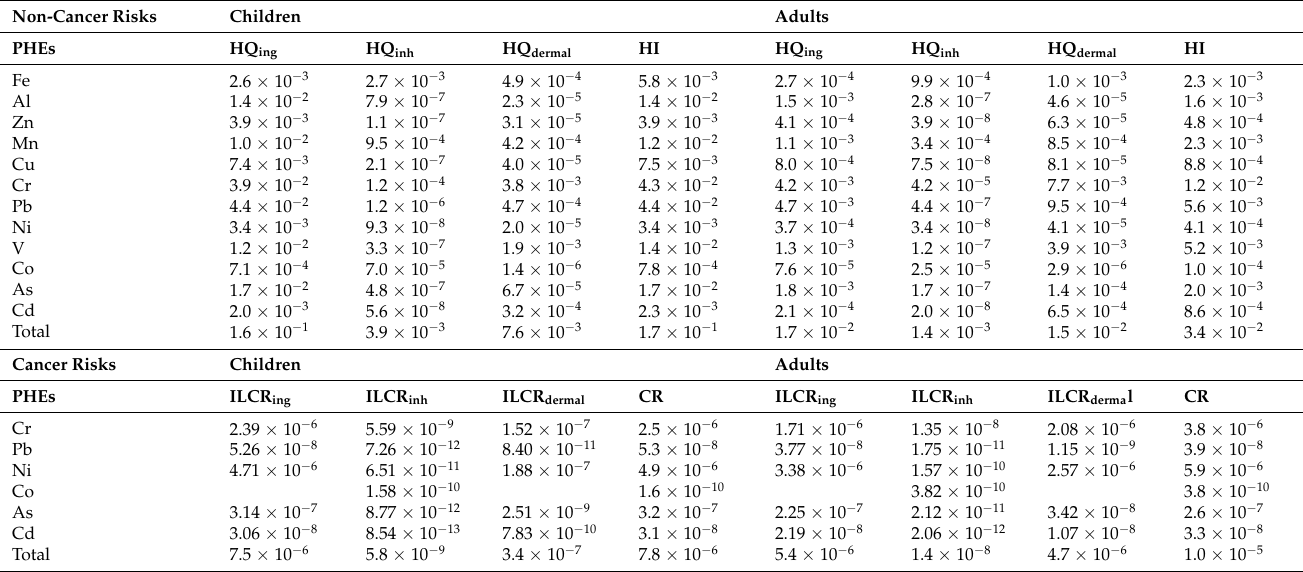
Table 5. Summary of hazard quotients (HQ), hazard index (HI), incremental lifetime cancer risk (ILCR), and cancer risk (CR) of PHEs in ACFD collected samples from Jeddah mosques via non-dietary ingestion, inhalation, and dermal contact exposure